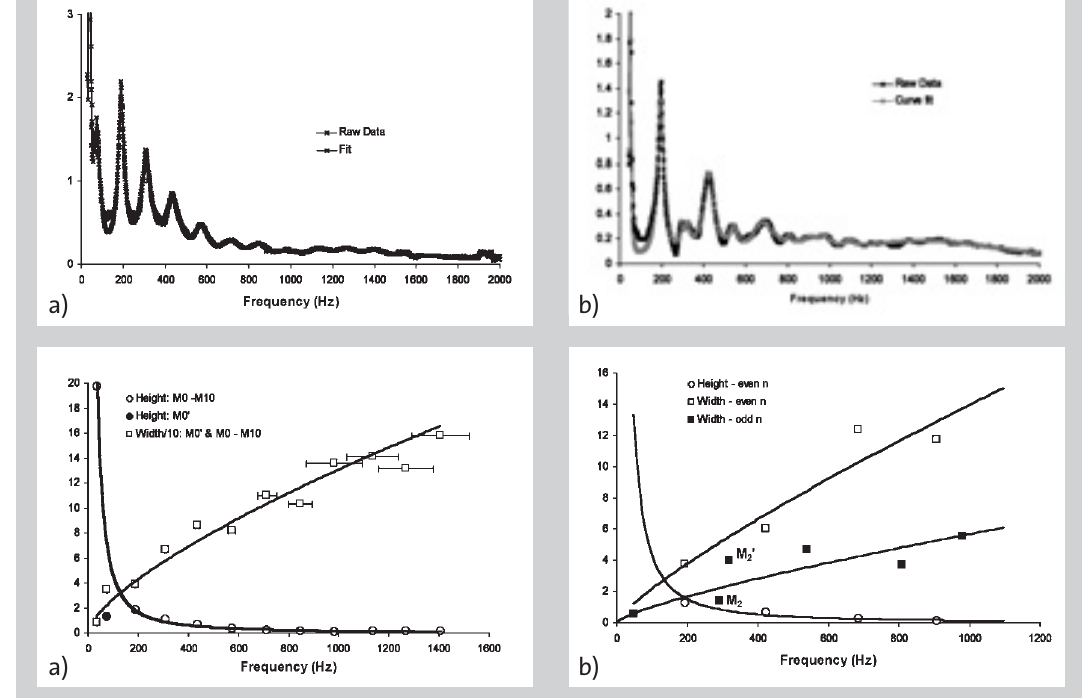
Figure 6 (below): Heights and widths of the individual peaks used in Figure 5 for interpretation of the real AFP plots. a/ vertical position;